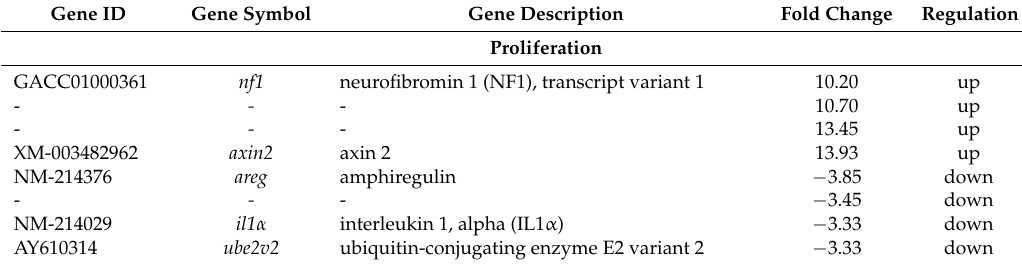
Table 3. List of the most strongly upregulated or downregulated genes involved in proliferation in